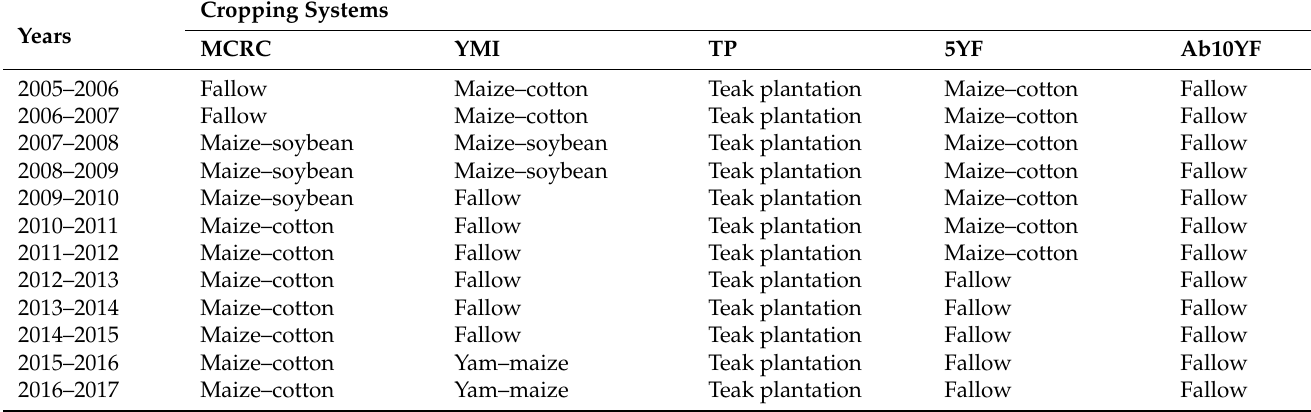
Table 1. Cropping systems